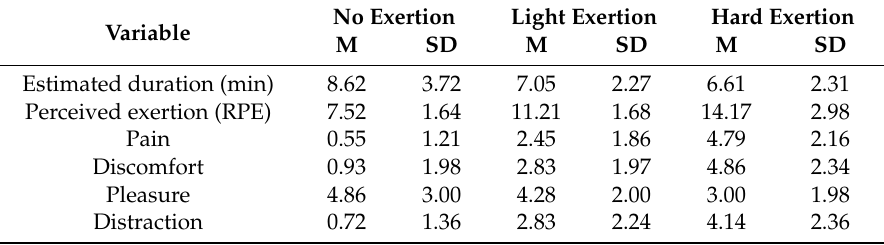
Table 2. Means and Standard Deviations of Estimated Duration, Perceived Exertion, Pain, Discomfort, Pleasure, and Distraction under Conditions of No Exertion, Light Exertion, and Hard Exertion in Experiment